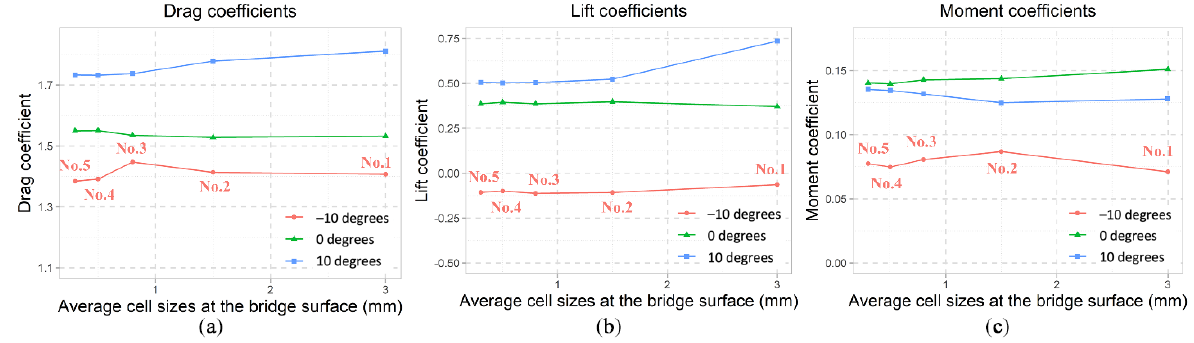
Figure 16. Comparison of aerodynamic coefficients in the mesh sensitivity study: ( a ) Drag coefficients; ( b ) Lift coefficients; ( c ) Moment coefficients.